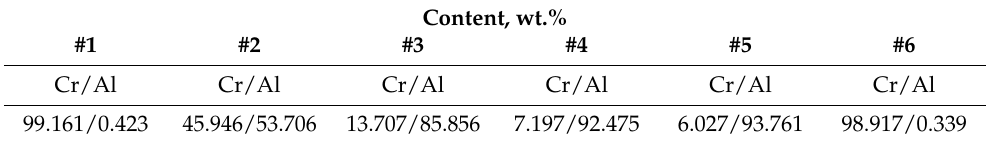
Table 5. Content of chromium and aluminum at the respective points of MeO–Me interfaces.